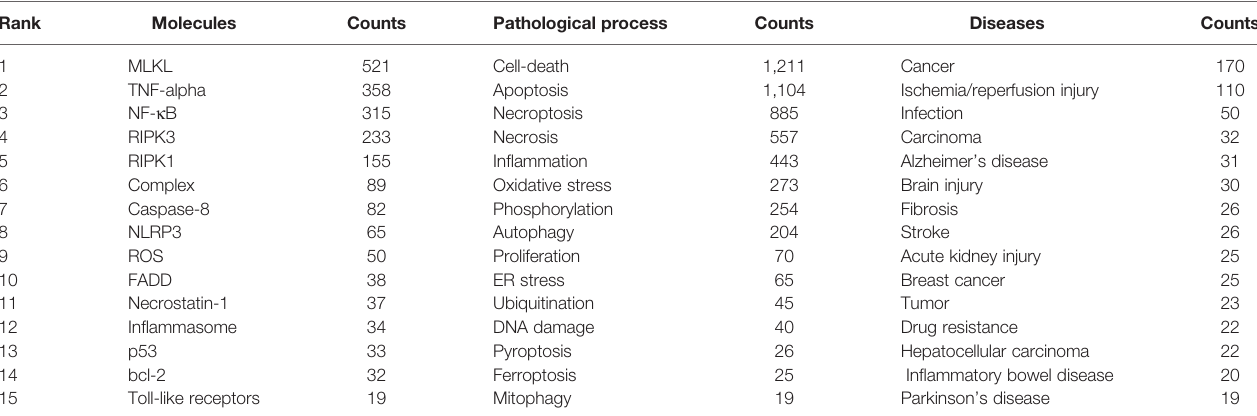
TABLE 6 | Top 15 molecules, pathological process and disease related to